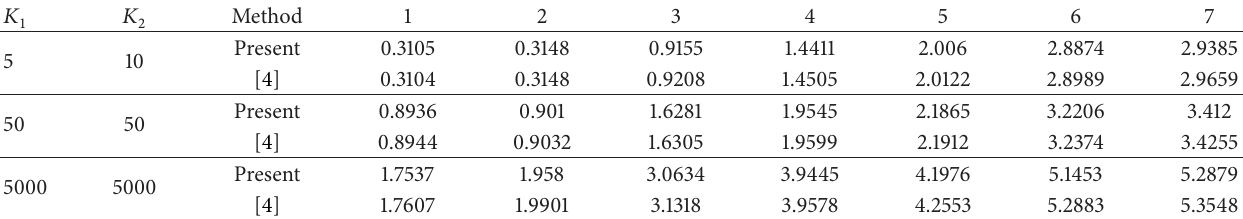
Table 7: The first seven frequency parameters Ω = ( 𝜔𝑏 2 / 𝜋 2 )( 𝜌ℎ/𝐷 ) 1/2 for Mindlin rectangular plates with two opposite free edges, the other two edges symmetrically elastically restrained 𝑘 𝑥0 = 𝑘 𝑥𝑎 = 𝐾 1 × 𝐷 and 𝐾 𝑥0 = 𝐾 𝑥𝑎 = 𝐾 2 × 𝐷 .